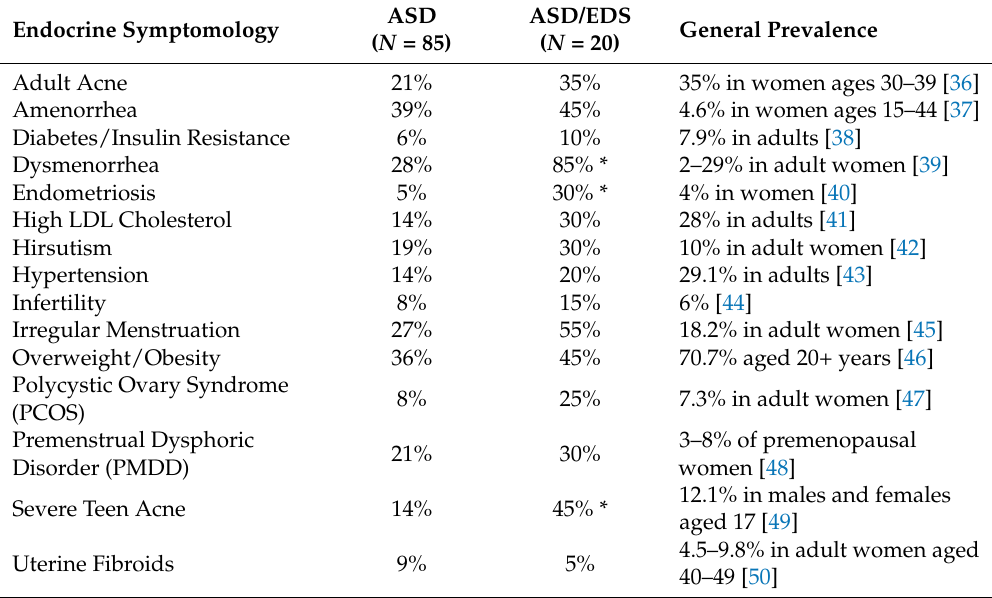
Table 3. Reported rates of various endocrine-related symptoms according to group, as well as estimated general prevalence